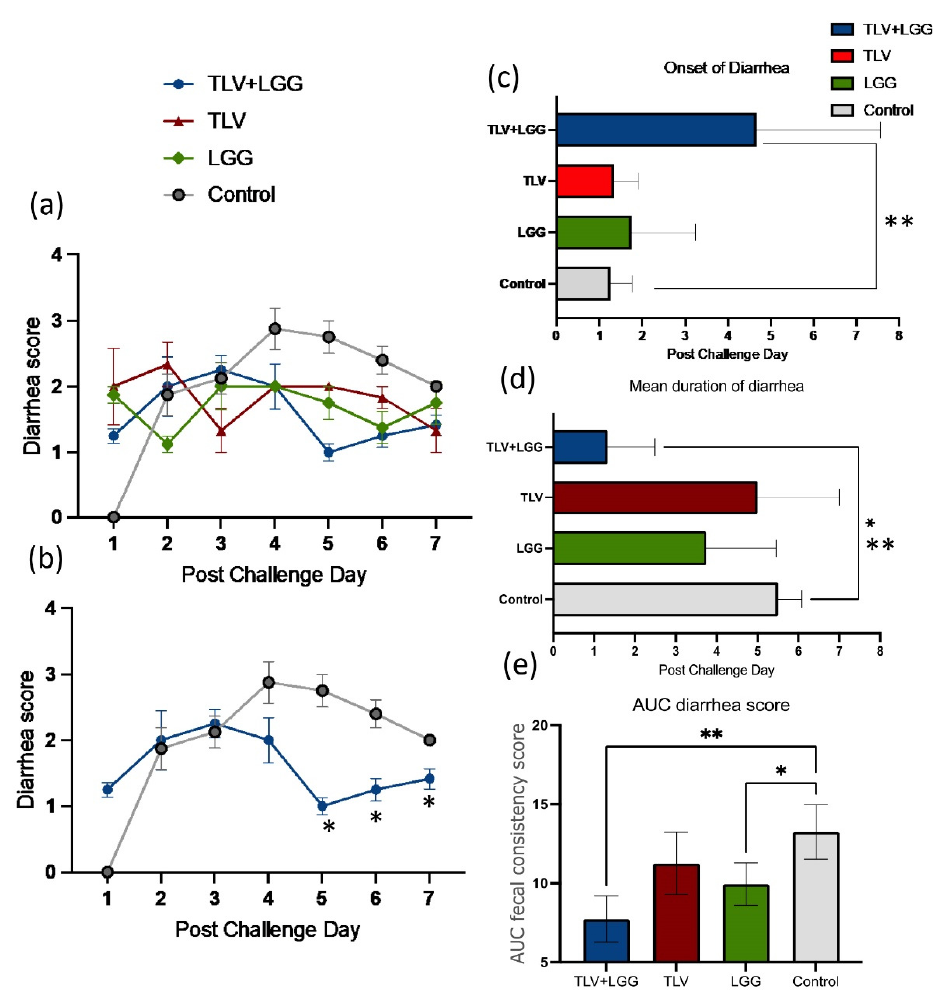
Figure 3. Protection against diarrhea upon virulent Wa HRV challenge. Pigs were challenged orally with virulent Wa HRV at PID 28 and monitored for 7 days post-challenge (PCDs 1–7) for duration and severity of diarrhea. * Indicates significant difference when comparing between two groups; ** indicates significant difference between the TLV+LGG group and all the other groups. ( a ) Mean diarrhea score from PCD 0 to 7 in all treatment groups. ( b ) Mean diarrhea score of TLV+LGG versus the control. ( c ) Mean days to onset of diarrhea. ( d ) Mean duration of diarrhea. ( e ) Mean area under the curve of diarrhea score.